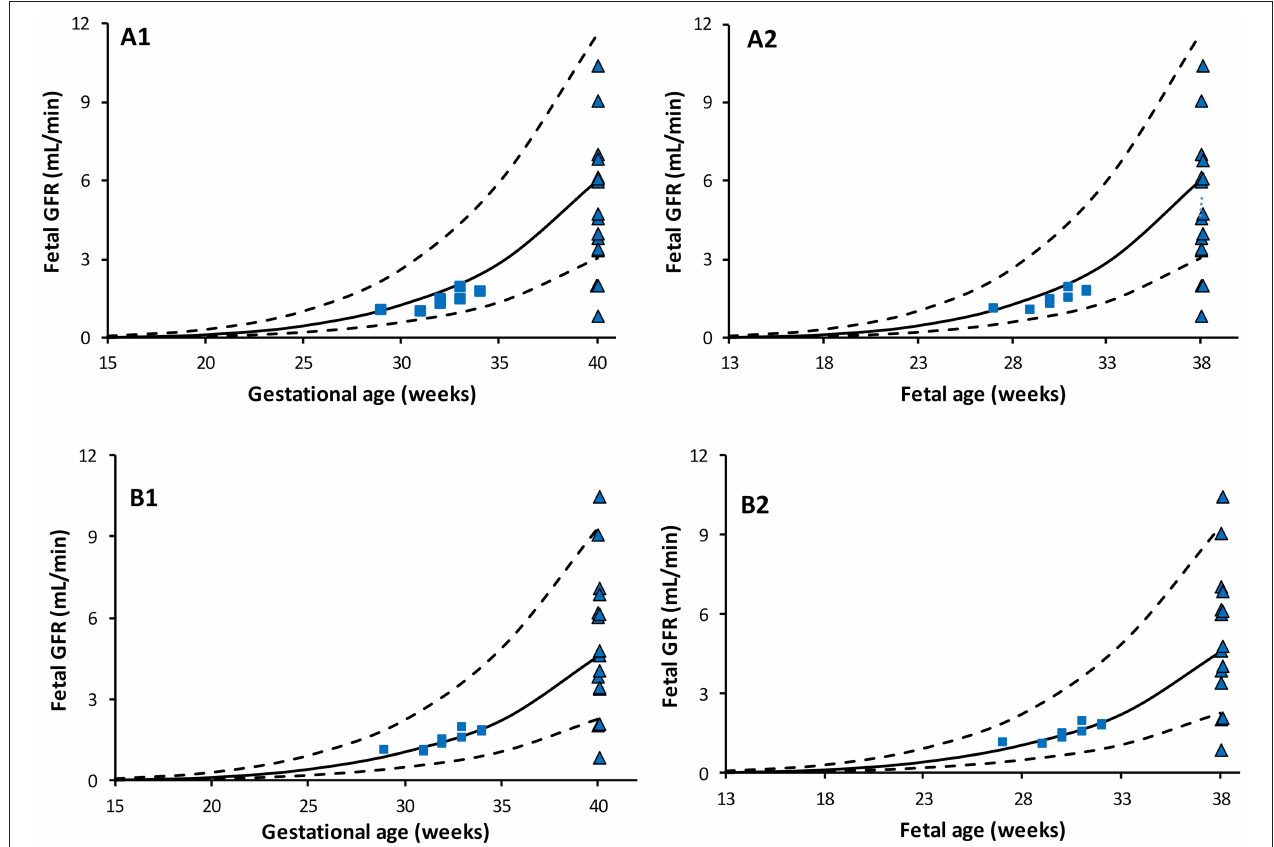
FIGURE 4 | Predicted Fetal GFR profiles at different gestational (left) and fetal (right) ages. Scenario (A) using maternal SerCr in place of fetal SerCr, while fetal UrCr used equation based on data that include normal fetuses (49) and fetuses diagnosed with uropathies (6, 48). Scenario (B) using maternal SerCr in place of fetal SerCr, while fetal UrCr is only based on “normal” fetuses as per Nicolini et al. Solid lines represent median, broken lines represent 5th and 95th percentiles. Shapes represent observed neonatal GFR measured within few hours after birth in full term [triangle, Strauss et al. (54)] and preterm [squares: Coulthard et al. (55)] subjects.